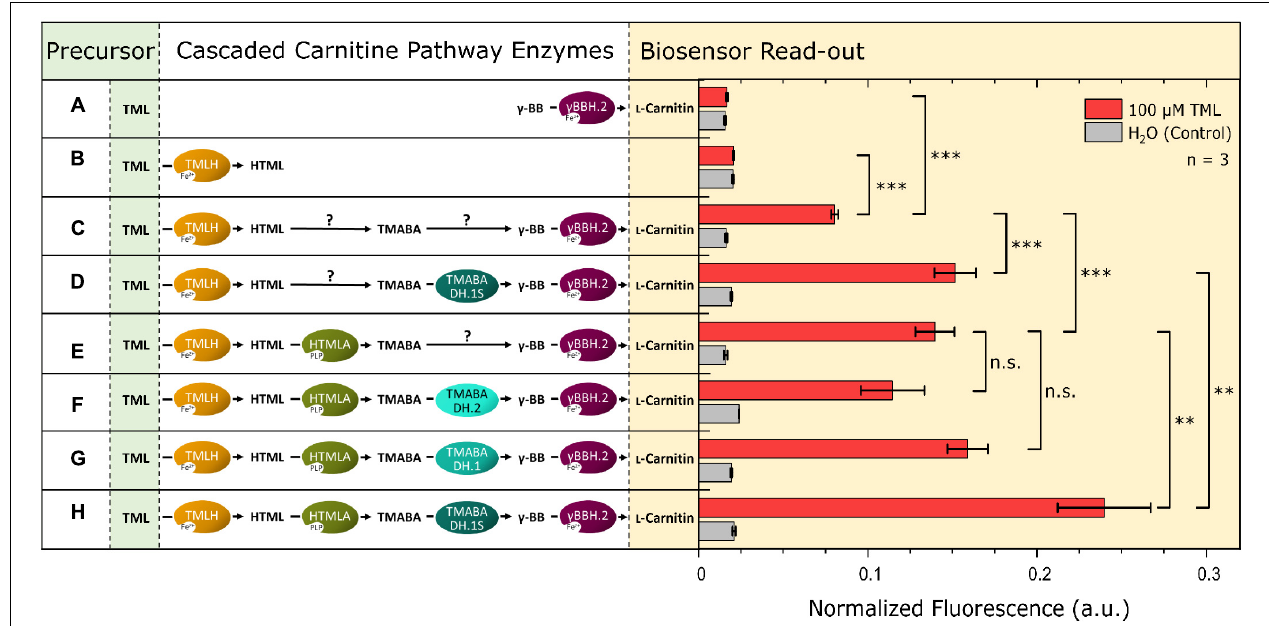
FIGURE 4 | Assembly of the four steps of the L -carnitine biosynthetic pathway of N. crassa in E. coli . The expression of a gene encoding a cascaded enzyme is depicted by an oval on the left side. Arrows marked with a “?” indicate that the reaction may proceed via endogenous enzymes although no dedicated gene was overexpressed. Plasmid pPLib3 was used for the individual expression of TMLH (pPLib3-TMLH; Combinations B, C, and D) and together with HTMLA as synthetic operon (pPLib3-TMLH-HTMLA; Combinations E, F, G, and H) and as empty vector control (pPLib3; Combination A). pECXT99A was used to express γ BBH.2 individually (pECXT99A- γ BBH.2; Combinations A, C, and E) or in a synthetic operon with one of the TMABADH variants (pPLib3-TMABADH.1S- γ BBH.2; Combinations D and H, pPLib3-TMABADH.1- γ BBH.2; Combination G, or pPLib3-TMABADH.2- γ BBH.2; Combination F) and as empty vector control (Combination B). The shown enzyme combinations were tested in the L -carnitine biosensor strain E. coli (cid:49) cai-fix (pGP2-Sensor1- caiCD ). The maximum normalized fluorescence signal observed during the cultivation process with 100 µ M TML (red columns) or water (gray columns) as the control is shown. Error bars indicate the standard deviation of the mean of three replicates. Three asterisks ( ∗∗∗ ) indicate a p -value ≤ 0.001 in a student’s t -test, ∗∗ p -value ≤ 0.01, and n.s., not